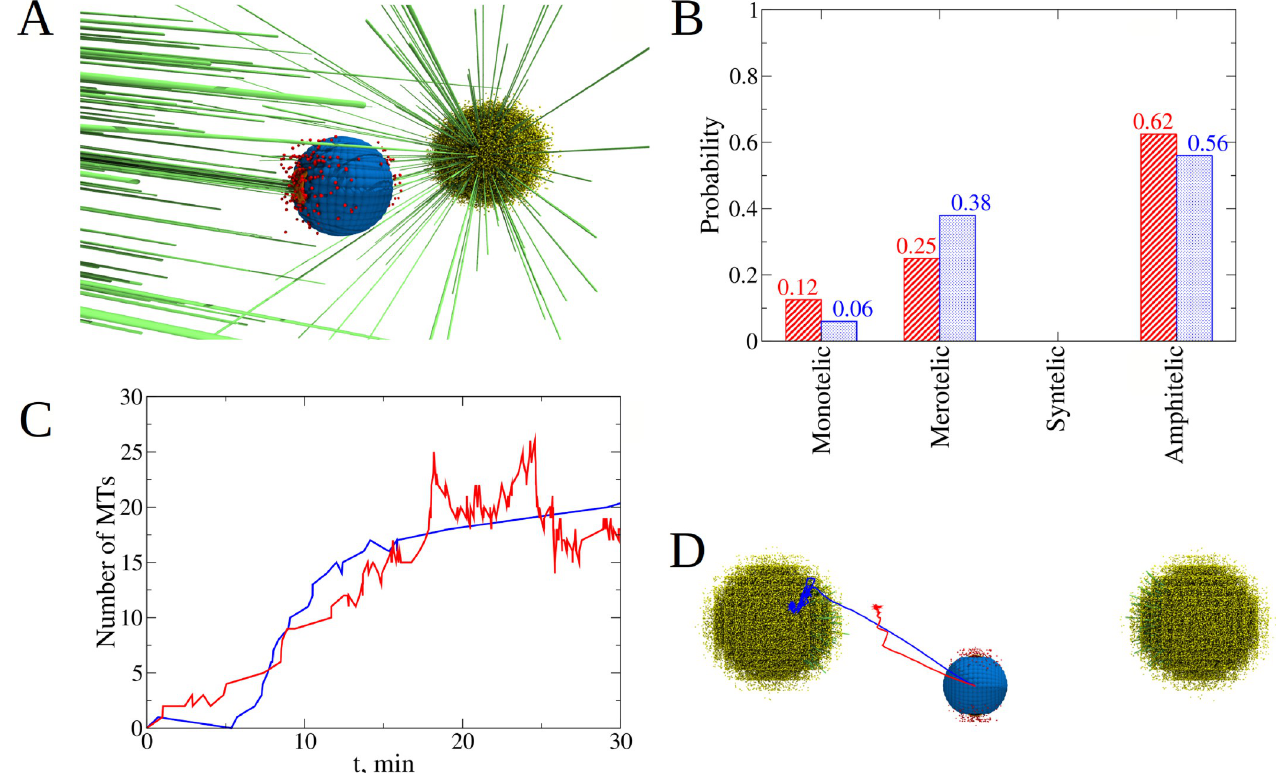
Fig 5. Exploring the effect of the Aurora A presence. A) Snapshot of the final KT pair position and orientation (amphitelic attachment) for a simulation with AA. B) Probability to find each type of attachment for the system without AA (blue bars) and for the system with AA (red bars). Statistics were collected from n = 20 simulation runs for both cases. C ) Addition of AA kinases to the system changes the Phosphatase to Aurora B ratio close to centrosomes (CSs). This influences the average bond lifetime and the frequencies of attachment/detachment switches. Blue line shows the evolution of total number of microtubules (MTs) attached to a single KT pair from both CSs for the case study without AA, red line shows the number of MTs for the case study with AA. D ) An example of how adding AA kinases to the system corrects the trajectory of the KT pair. Lines show the 2D projection ( xz -plane) of the KT pair trajectory during 30 min simulations. For the case study without AA (blue line), KT pair reaches one of the CSs and for the case study with AA (red line), KT pair stops right before the cloud of AA kinases.